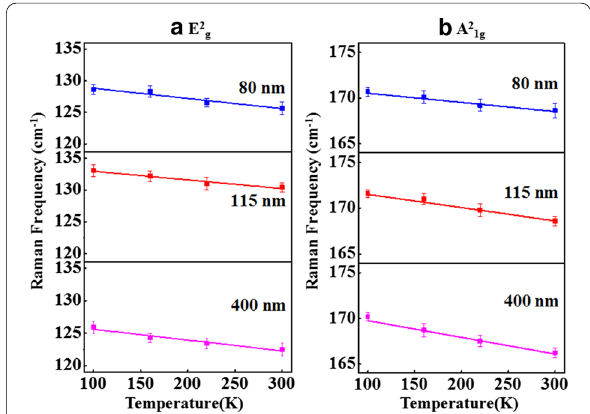
Fig. 6 Raman frequency vs. temperature plots of a E 2 g mode and b A 2 1g mode for 80-nm, 115-nm and 400-nm Sb 2 Te 3 flakes. The solid lines are the linear fits to the experimental data (symbols). The uncertainty in the Raman frequency measurement has been shown as error bars